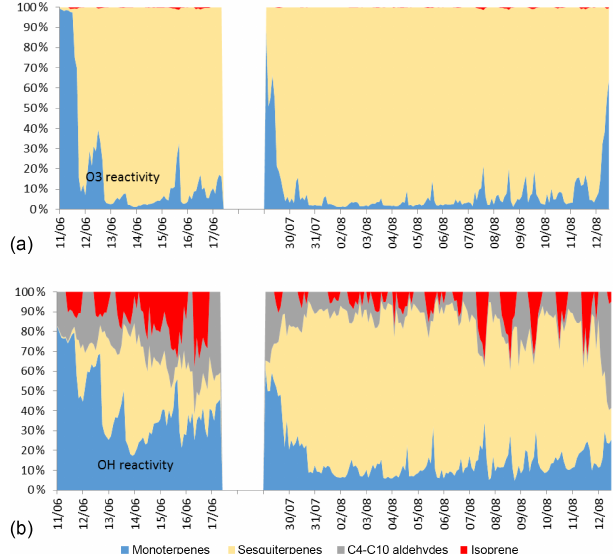
Figure 5. Relative O 3 and OH reactivity of emissions for two pe- riods in early and late summer 2015. The compounds and reaction coefficients used for reactivity calculations are presented in Table